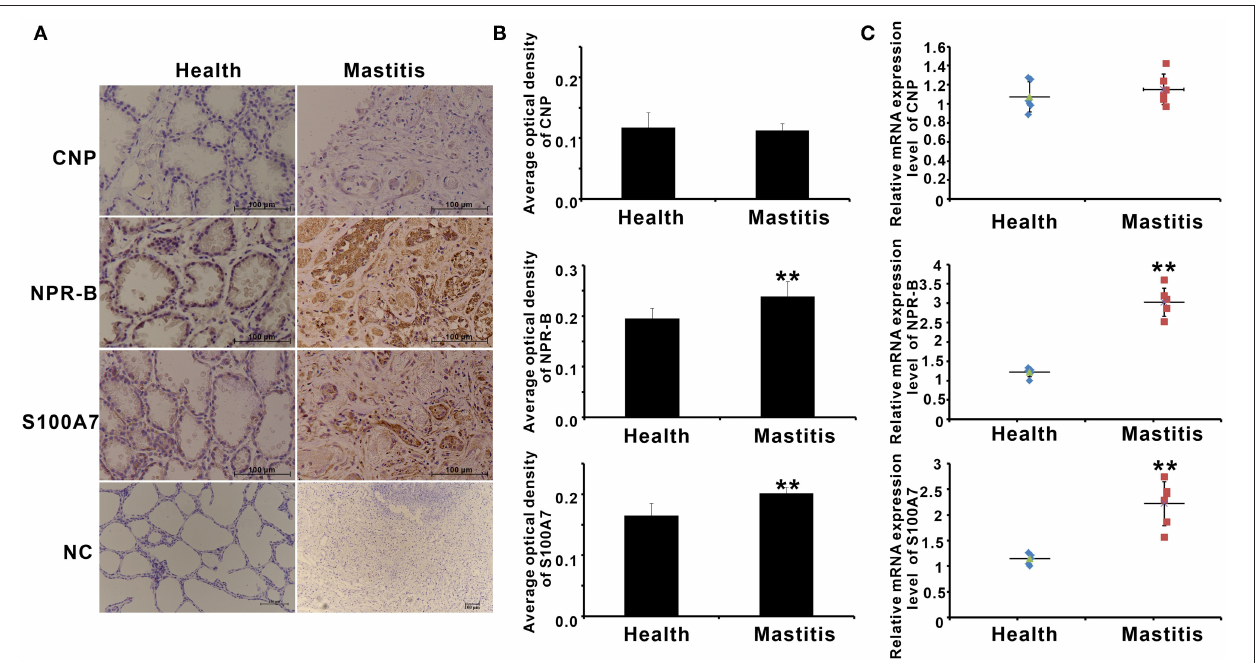
FIGURE 6 | The expression of CNP, NPR-B, and S100A7 in healthy and mastitis goat mammary glands. (A) Representative images of immunohistochemistry showing the expression of CNP, NPR-B, and S100A7 in healthy and mastitis goat mammary glands. (B) Quantitative analysis of average optical density (AOD) of CNP, NPR-B, and S100A7 in healthy and mastitis goat mammary glands. (C) , Quantitative PCR results showing the mRNAs expression level of CNP, NPR-B, and S100A7 in healthy and mastitis goat mammary glands. ** p < 0.01 (compared to the healthy